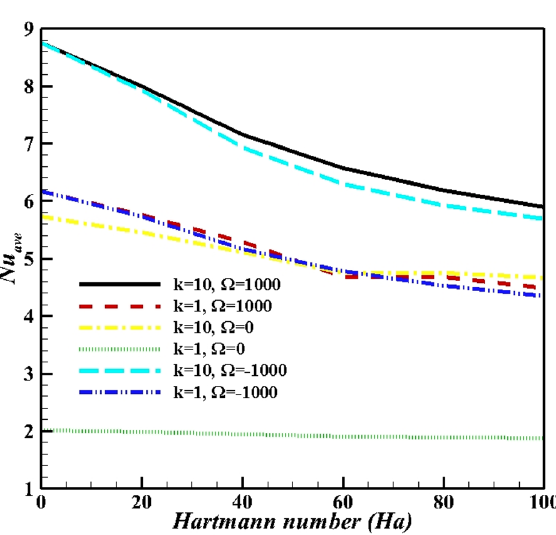
Figure 15. Average Nusselt number for different Hartman numbers at Ra = 10 6 ,